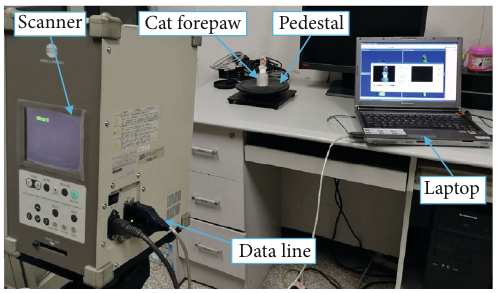
Figure 2: Scanning system for the cat